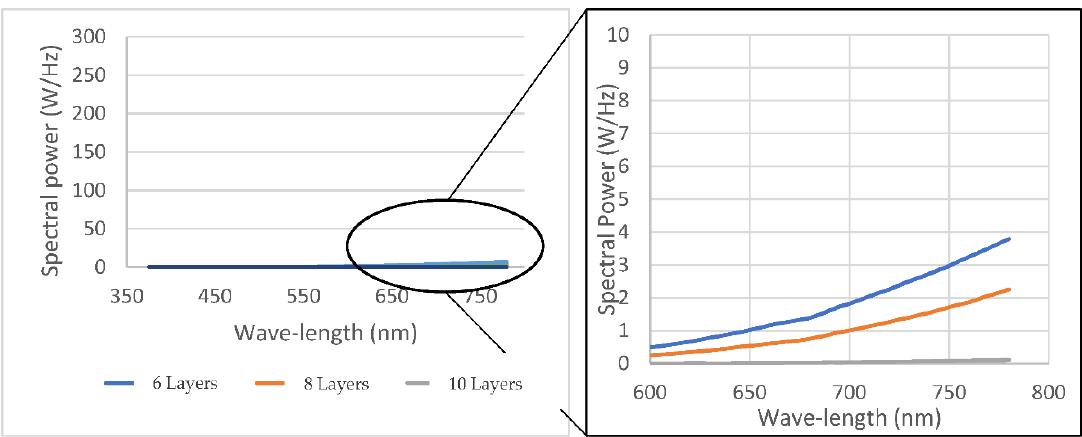
Figure 11. Relative distribution of spectral power for an Illuminant A light in the studied samples between 350 nm and 750 nm.